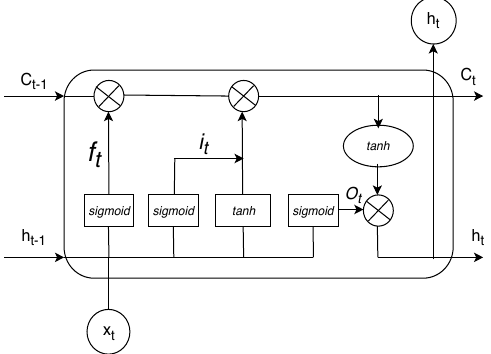
Figure 1. The structure of long short-term memory (LSTM)